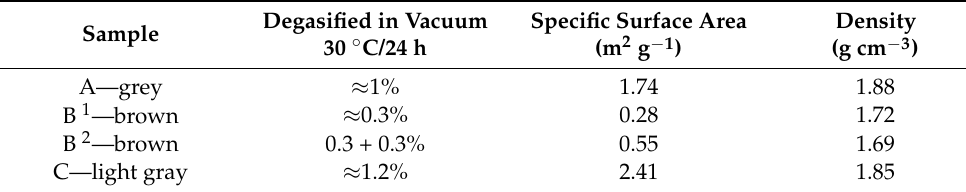
Table 1. Surface area of dust samples.